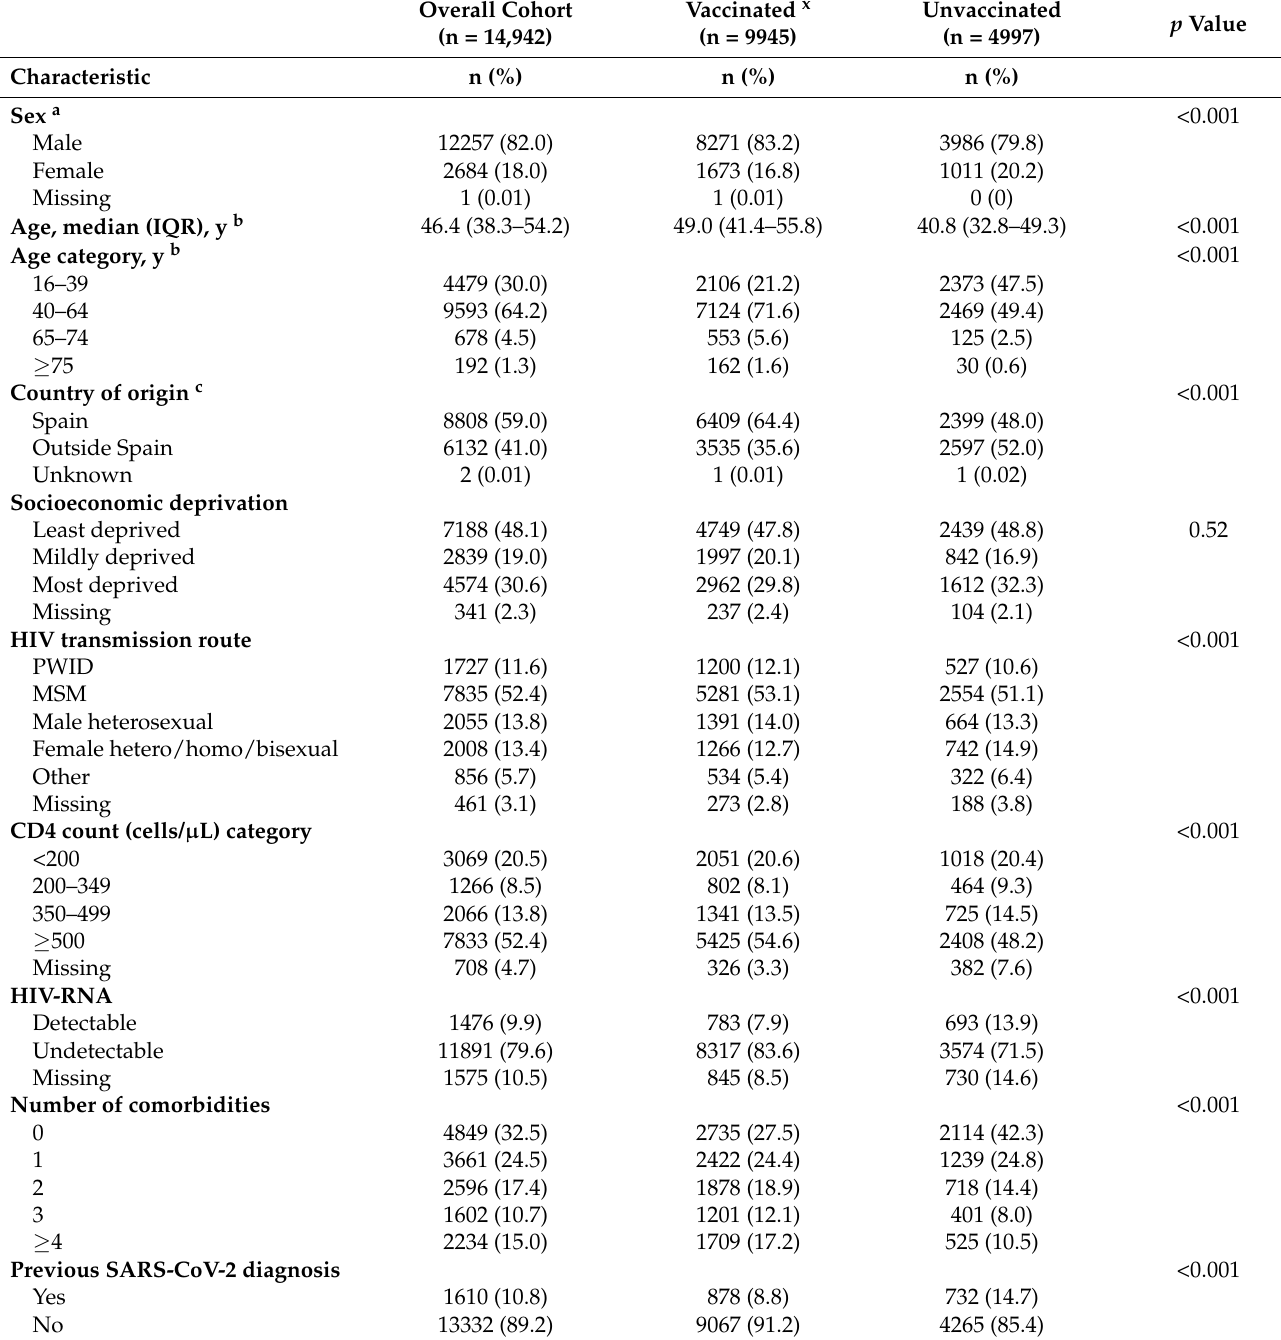
Table 1. Baseline characteristics of people living with HIV in Catalonia according to